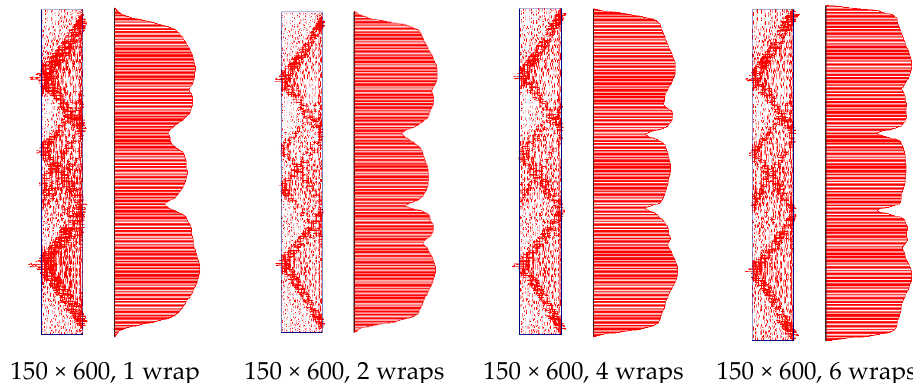
Figure 7. Half cross-section of the 150 mm × 600 mm cylinder with localized failure and the FRP wrap hoop strain profile at peak FRP strain = 1.5%.